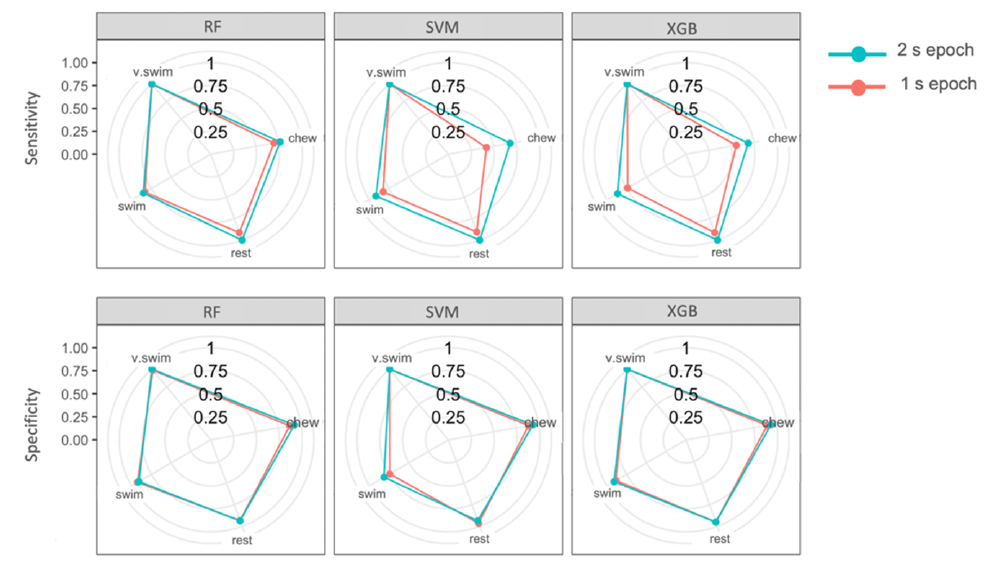
Figure 5. Sensitivity and specificity of random forest (RF), support vector machine (SVM) and eXtreme gradient boosting ( XGB) of the four behaviour classes for the 1 and 2 s epochs. The centre of the circles is 0% sensitivity or specificity and the performance increases moving outward.